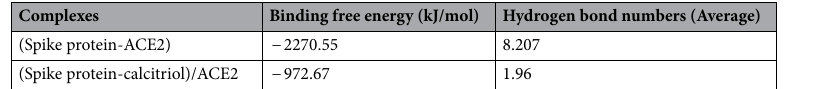
Table 2. Binding free energy and average number of hydrogen bonds in the spike-ACE2 complex in the absence or presence of calcitriol estimated during the last 100-ns MD simulation (from 200 to 300 ns).